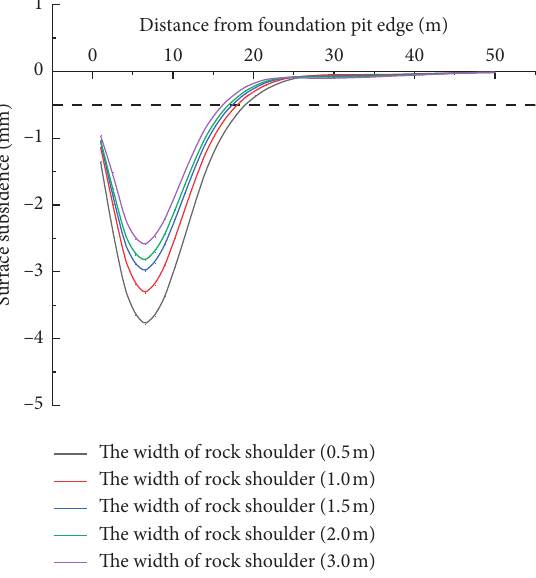
The width of rock shoulder (0.5m) The width of rock shoulder (1.0m) The width of rock shoulder (1.5m) The width of rock shoulder (2.0m) The width of rock shoulder Figure 11: Surface subsidence outside the